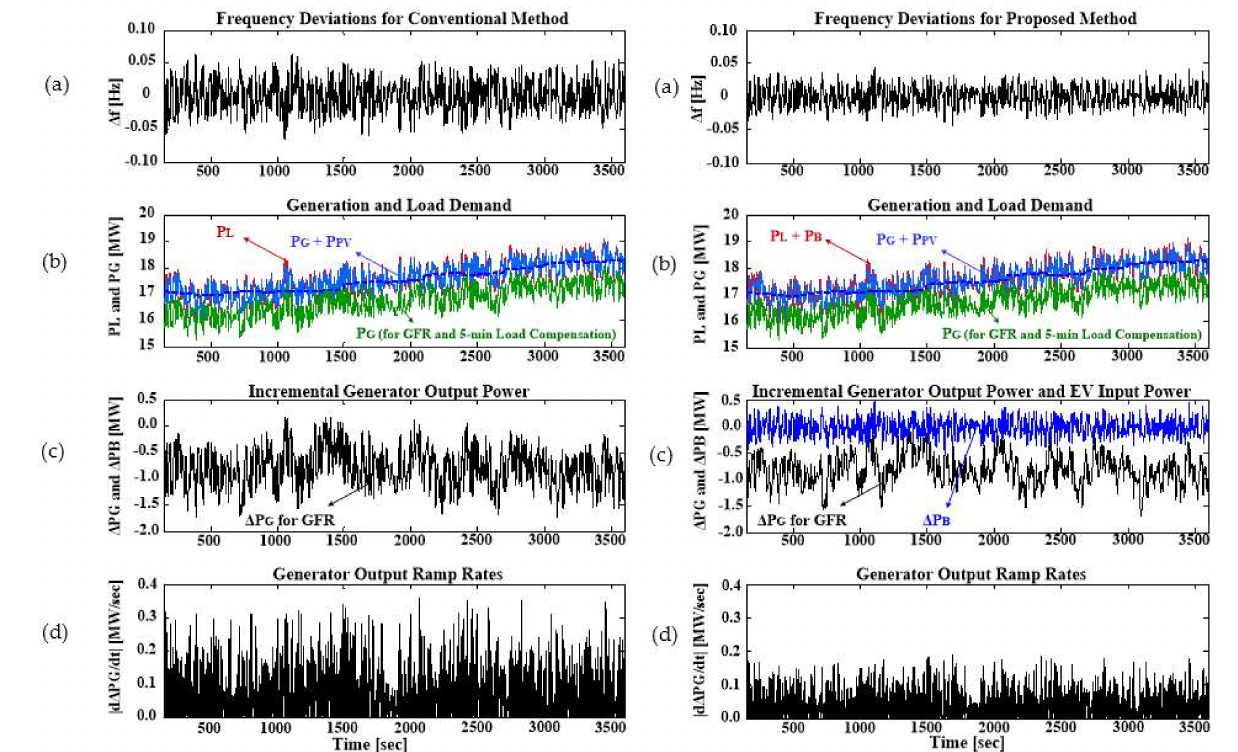
Figure 15. Experimental case study results for the ( left ) conventional and ( right ) proposed FR strategies: ( a ) frequency deviations ∆ f , ( b ) load demands P L , dispatchable generation P G , and total generation P G + P PV , ( c ) variations in generator output power ∆ P G and in battery input power ∆ P B , and ( d ) dynamic ramping rate of generation | d ∆ P G / dt